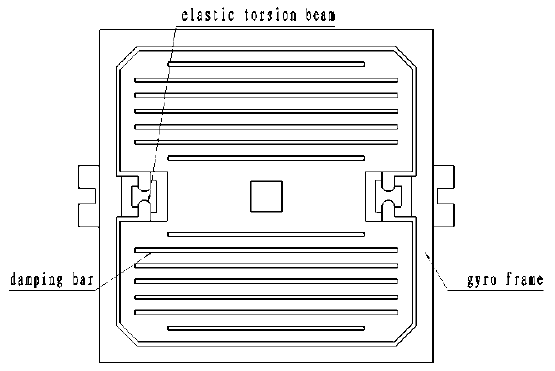
Figure 10. Silicon pendulum structure.